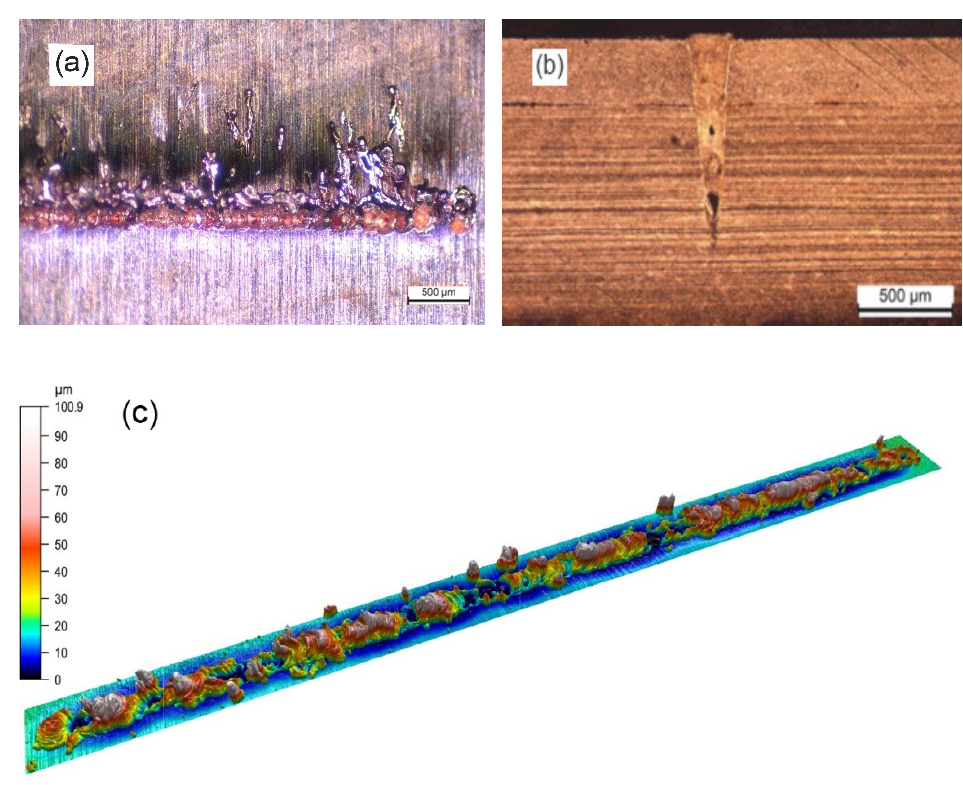
Figure 4. ( a ) Top view, ( b ) cross-section, and ( c ) 3D surface plot of the sample made without beam oscillation. Laser beam welding parameters were P = 750 W, PRR = 20 Hz, PW = 10 ms, V w = 2 mm/s, and gas flow = 15 L/min.